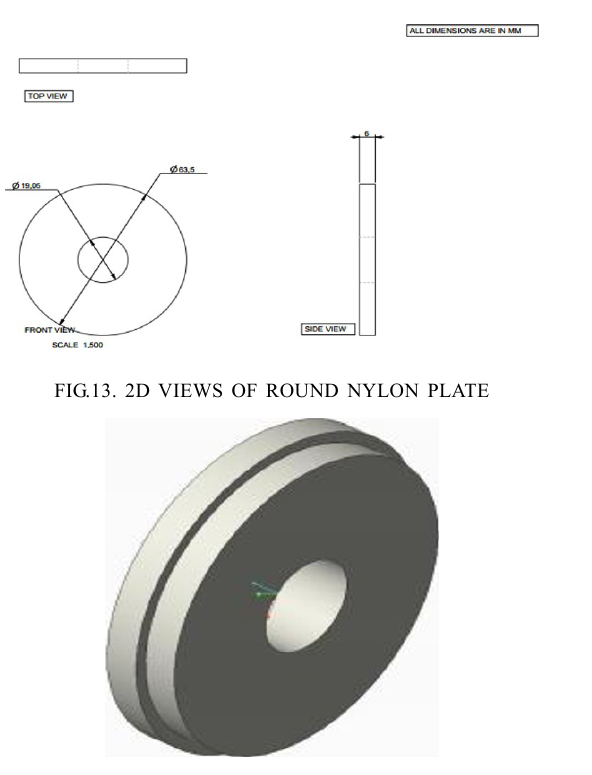
FIG.16 2D VIEWS OF STOPPER